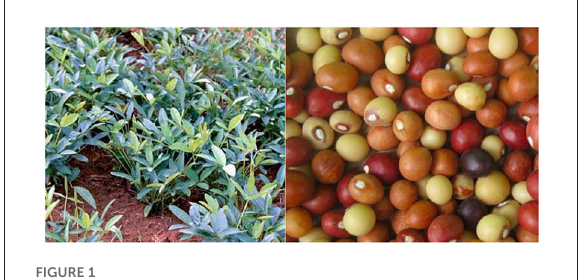
FIGURE1 Bambara groundnut in leaf and the